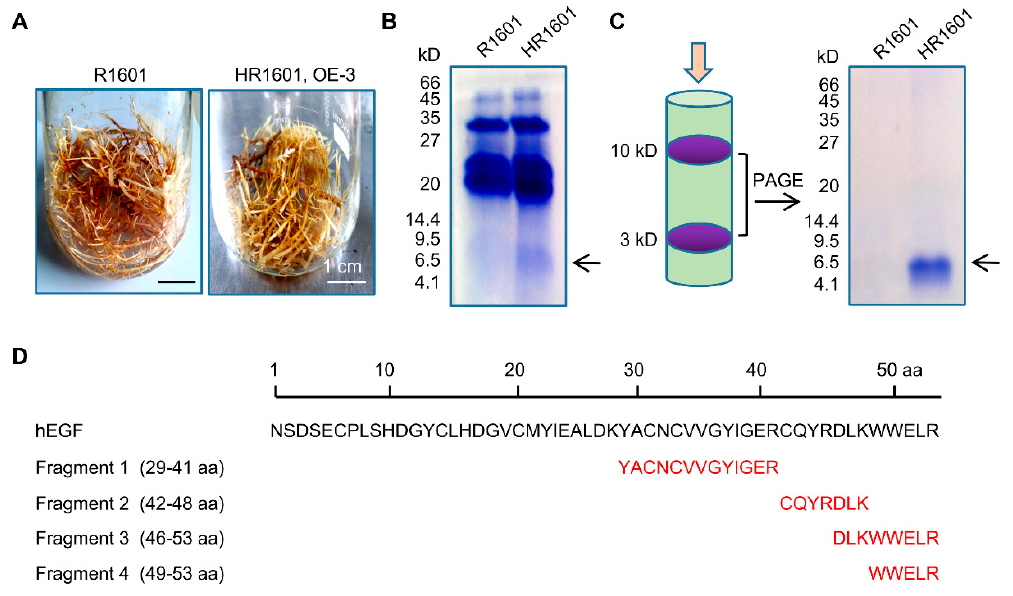
Figure 3. The identification of hEGF via matrix-assisted laser desorption / ionization time of flight mass spectrometry (MALDI-TOF-MS). ( A ) Pictures represent the peanut hairy root lines cultured in 100 mL of MS liquid medium for one month. Peanut hairy roots infected with Agrobacterium rhizogenes R1601 were used as the negative control. ( B ) SDS-PAGE analysis of the total protein samples extracted from peanut hairy roots infected with Agrobacterium rhizogenes R1601 or HR1601. Protein band indicated by the arrow is hEGF protein. ( C ) SDS-PAGE was used to isolate hEGF protein from the interception proteins again. The target protein hEGF is about 6 kDa. Protein band indicated by the arrow is hEGF protein. ( D ) Proteolytic enzyme trypsin was used to perform specific protein digestion at lysine and arginine and four short peptide sequence were identified by MALDI-TOF-MS analysis.